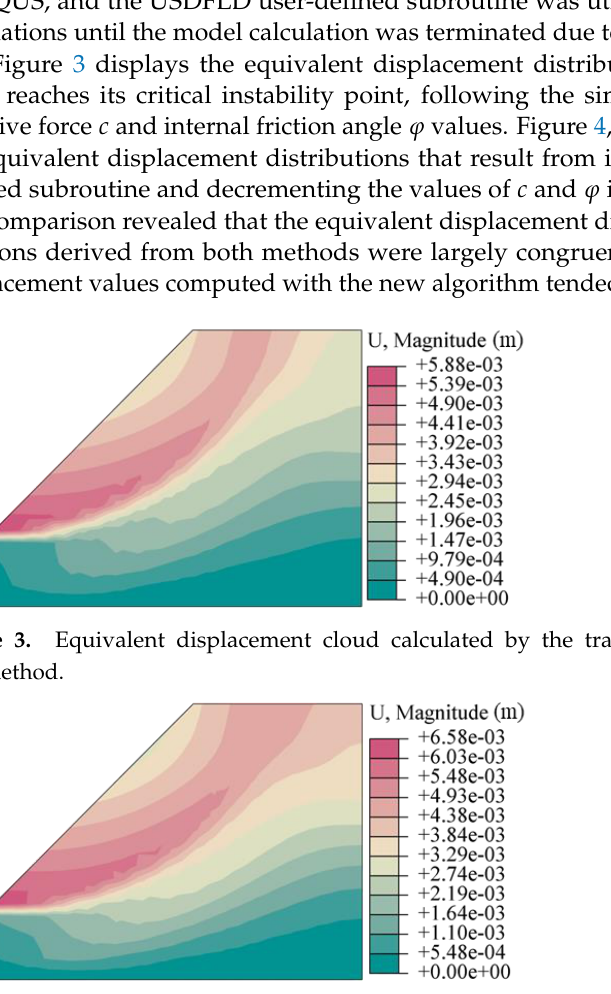
Figure 2. Numerical model of slope.